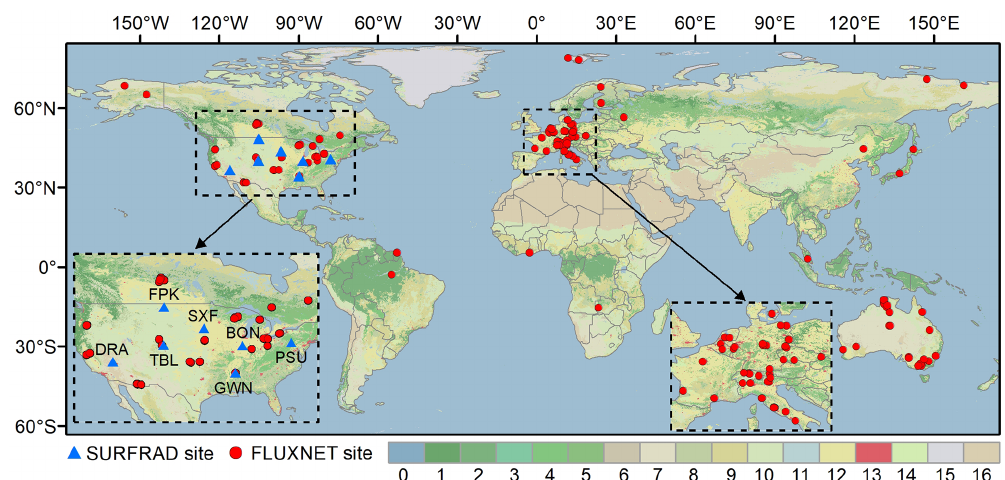
Figure 1. Geolocation of the stations used for validation. The red circles and blue triangles represent the locations of the FLUXNET and SURFRAD sites, respectively. The numbers “0” to “16” at the bottom represent the background land cover type as defined by the International Geosphere-Biosphere Programme (IGBP) (Friedl et al.,